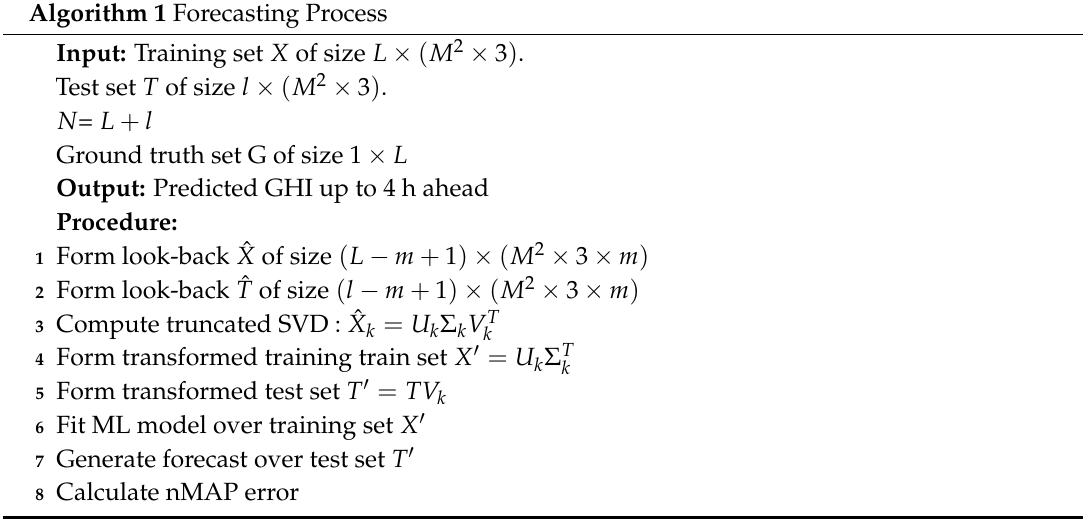
Algorithm 1 Forecasting